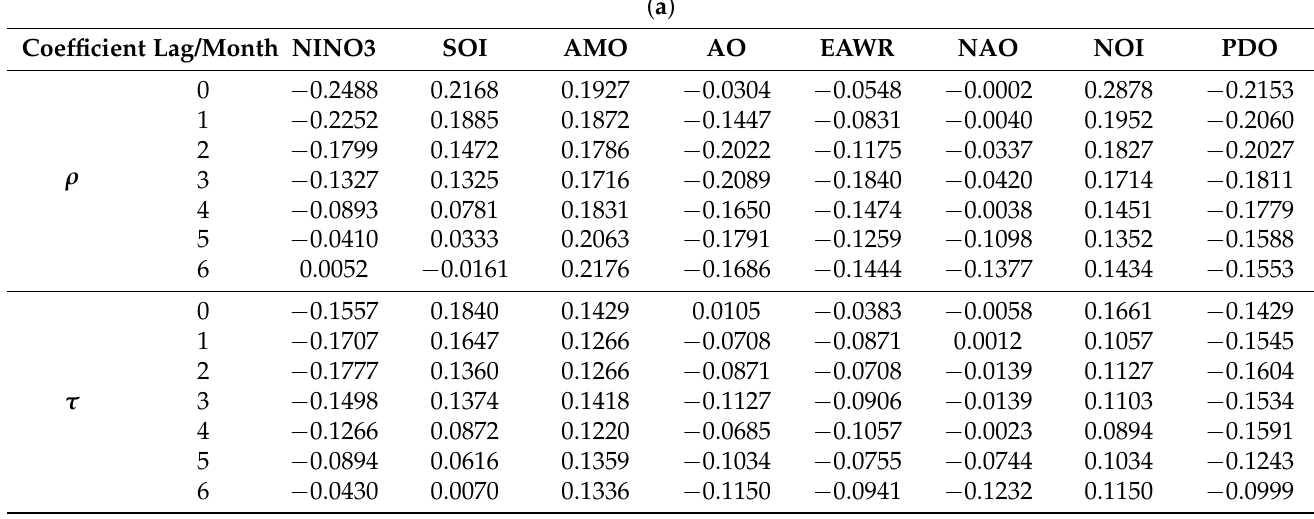
Table A5. The Pearson correlation coefficient ρ and the Kendall correlation coefficient τ between the time series of annual ( a ), winter ( b ) and autumn ET 0 ( c ) and climate indices under lags from 0- to 6- month. Bold means statistically significant at the level of